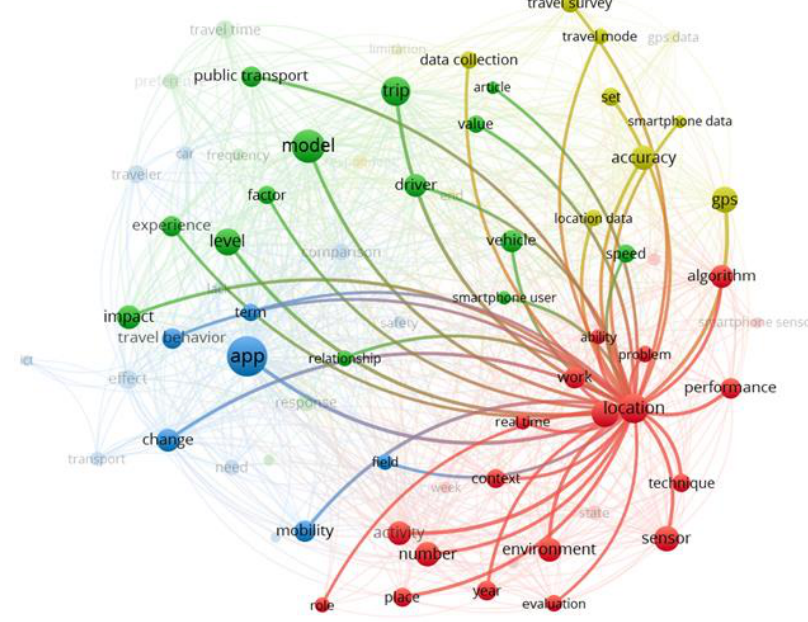
Figure 3. Co-occurrences of “ location ” . Source: VOSviewer.